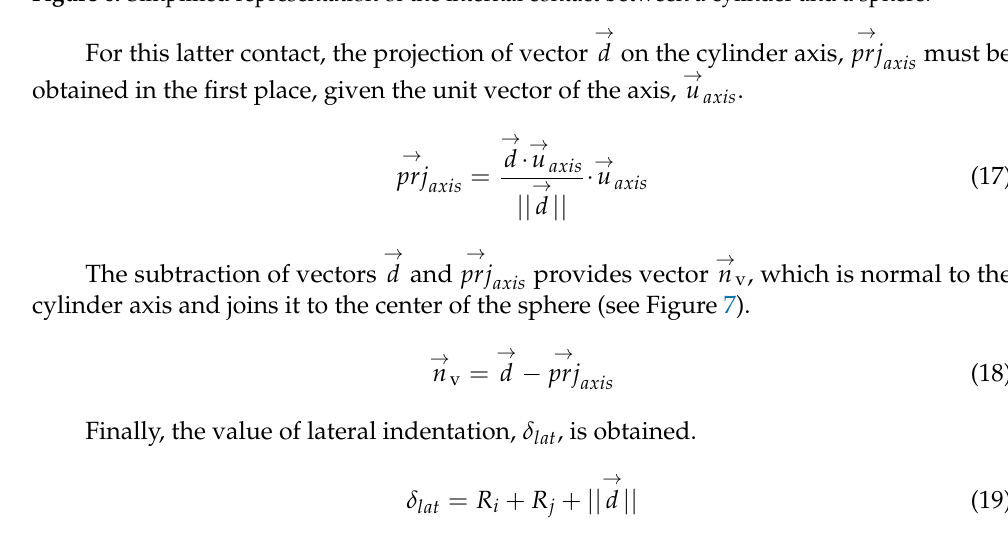
Figure 6. Simplified representation of the internal contact between a cylinder and a